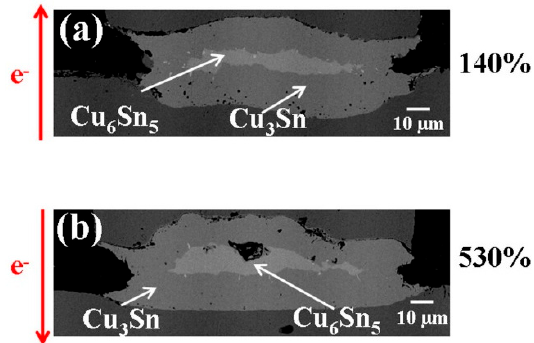
Figure 8. Cross-sectional SEM images of solder bumps with Cu column UBM stressed at 1.20 × 10 4 A/cm 2 at 170 °C with bump resistance increases ( a ) 140% with upward electron flow and ( b ) 530% with downward electron flow.